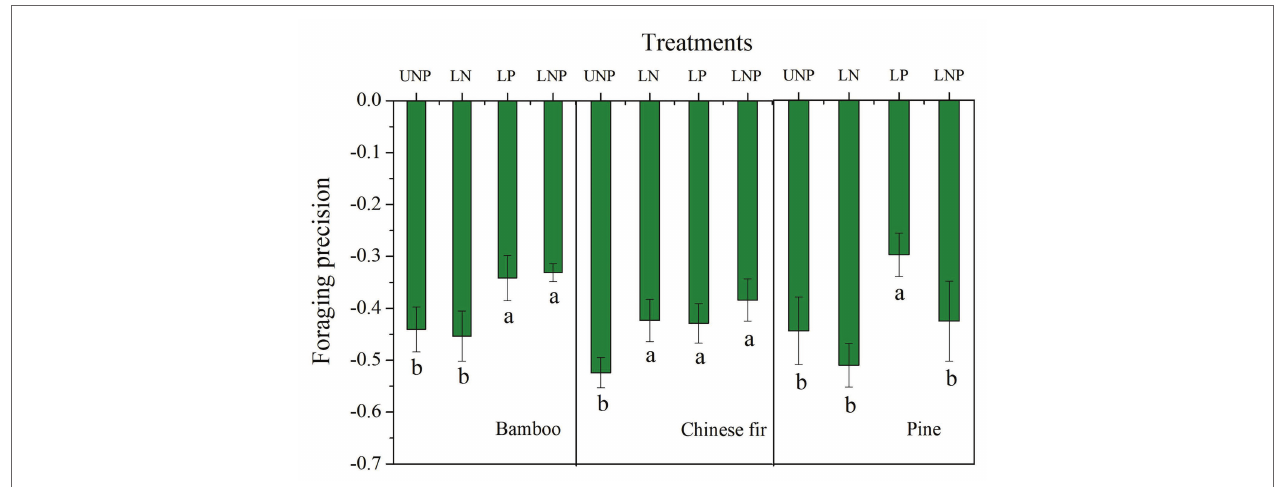
FIGURE 7 | Effects of different nutrient supply treatments on the foraging precision of the three tree species. Different lowercase letters denote significant differences among treatments within the same soil layer ( p < 0.05).